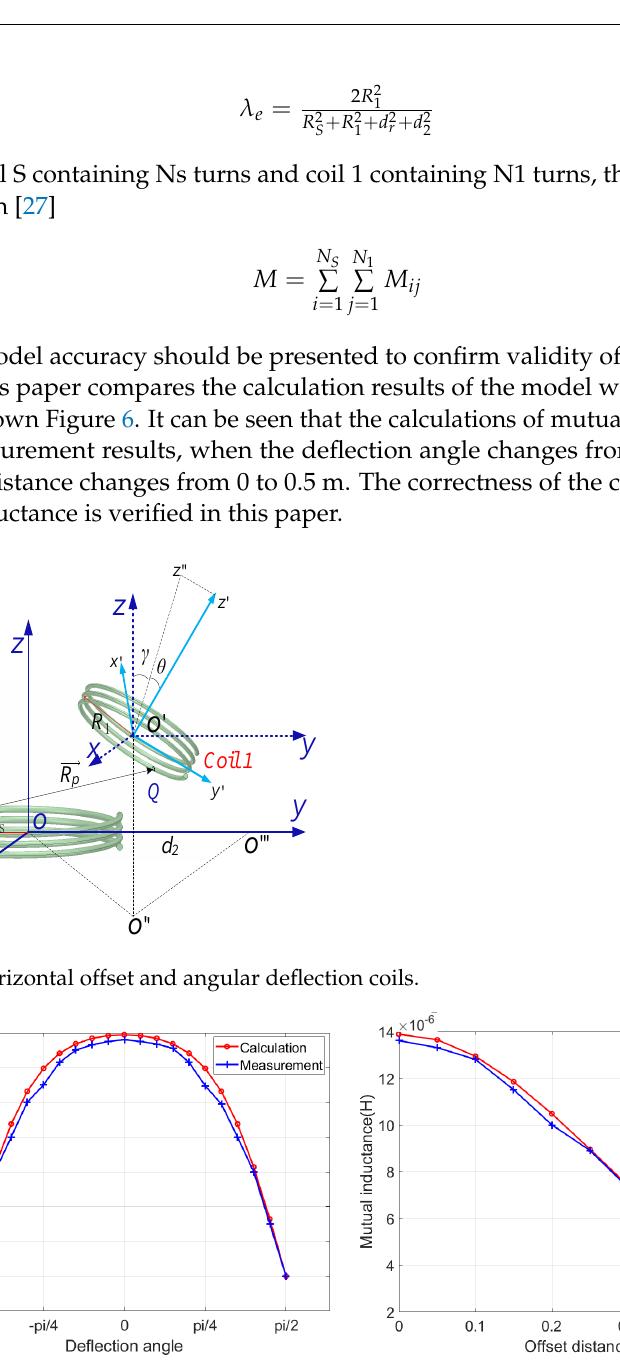
Figure 6. The verification of mutual inductance formula.The coil parameters are the same in calcula- tion and